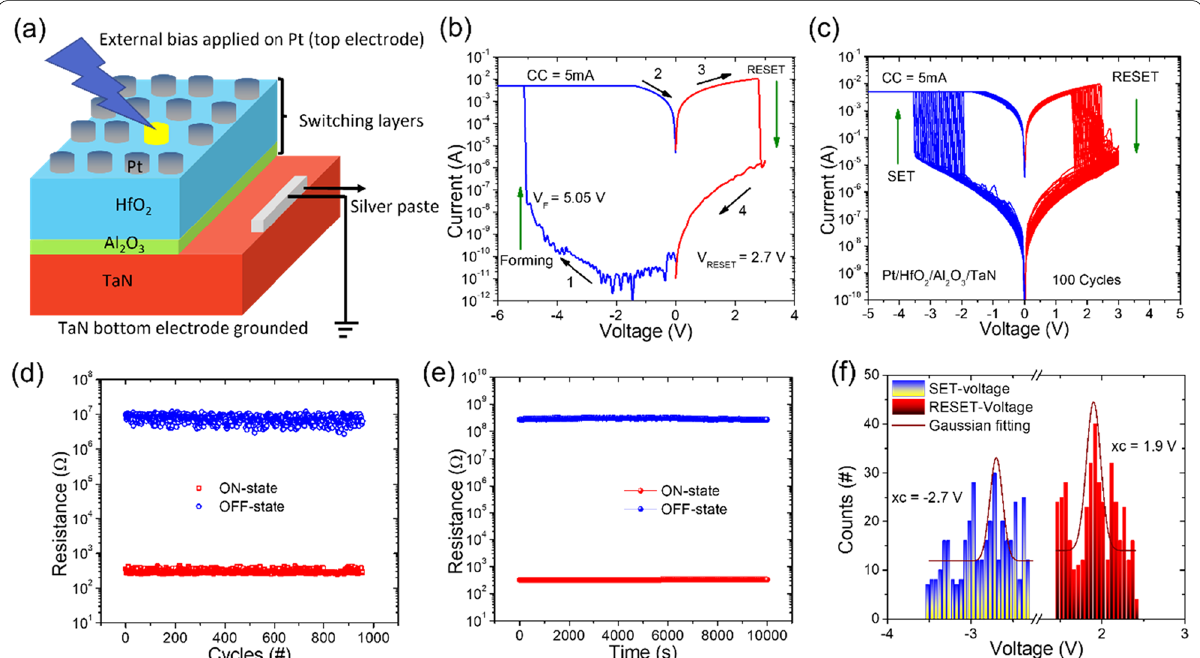
Fig. 2 a Schematic diagram of Pt/HfO 2 /Al 2 O 3 /TaN memristive device in electrical measurement configuration, which shows that the external voltage is applied to the Pt top electrode with the TaN bottom electrode electrically grounded. b I–V curves of an electroforming process (blue) and reset process (red). The arrows and numbers represent voltage sweep directions and sequences, respectively. c Typical bipolar I–V characteristics of 100 consecutive cycles, where green arrows indicate the set and reset directions. d DC endurance test results over 1000 cycles; the values of ON-state and OFF-state resistances were read at 0.2 V under ambient conditions. e Data retention characteristics of ON state and OFF state under ± a constant voltage stress of 0.2 V for 10 4 s at room temperature. f Statistical distribution analyses of set and reset voltages for the 100 switching